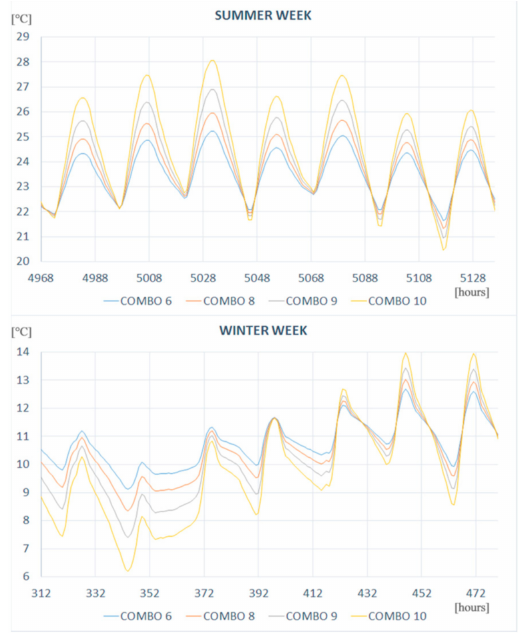
Figure 14. Trend of for Combos 6, 8, 9, and 10 (27 July–2 August; 14–20 January) for the outlet temperature Tout from the geothermal